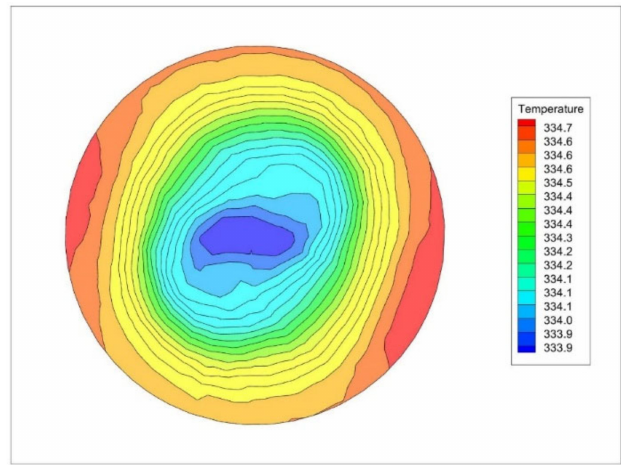
Figure 22. Temperature distribution at 0.25 m